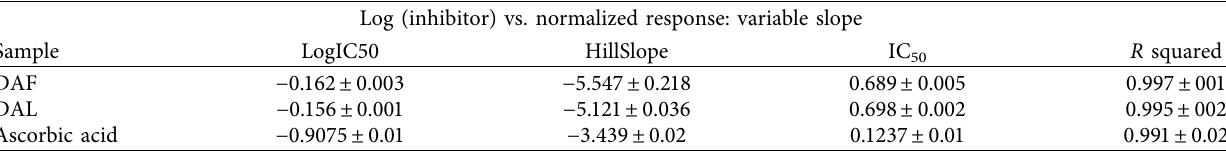
Table 5: Result summary of IC